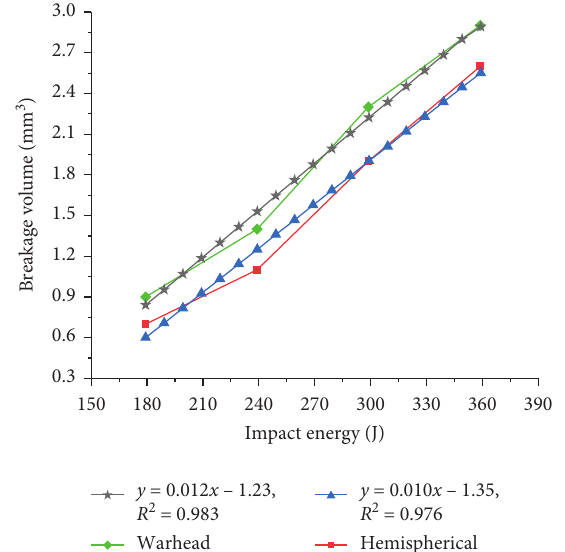
Figure 17: Rock breakage volume versus impact energy.